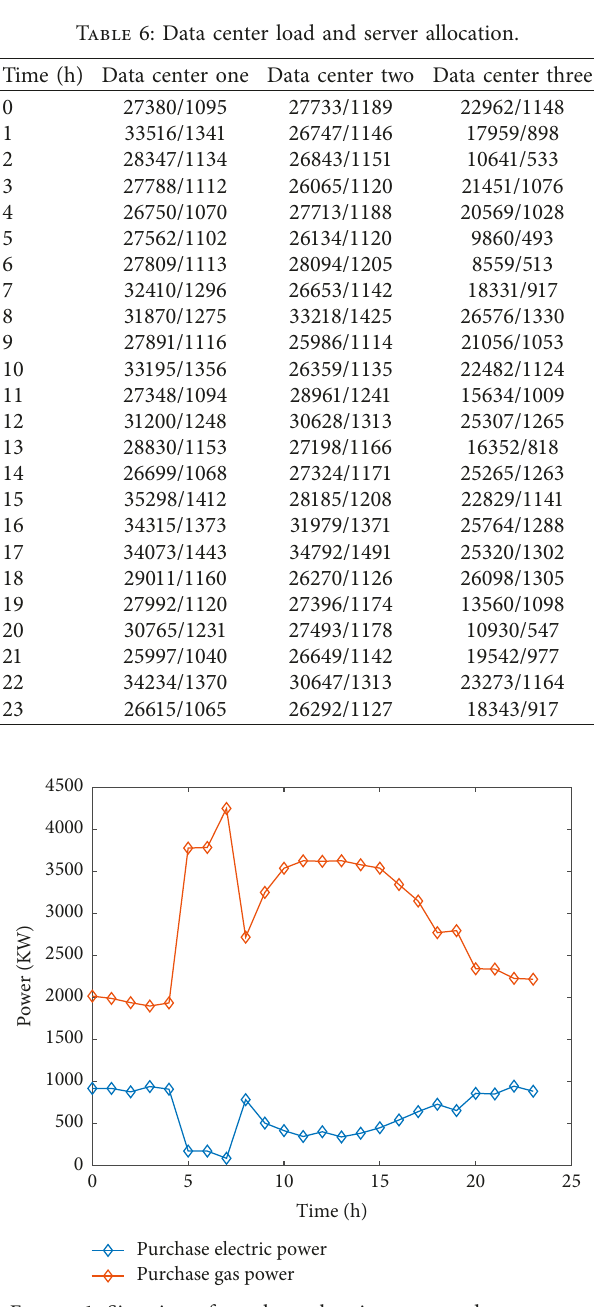
Figure 1: Situation of purchase electric power and gas power.